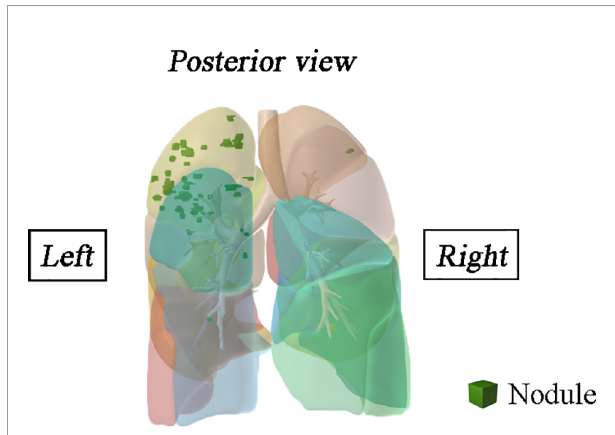
FIGURE 3 | Spatial location information of the multifocal samples of a patient was reconstructed in